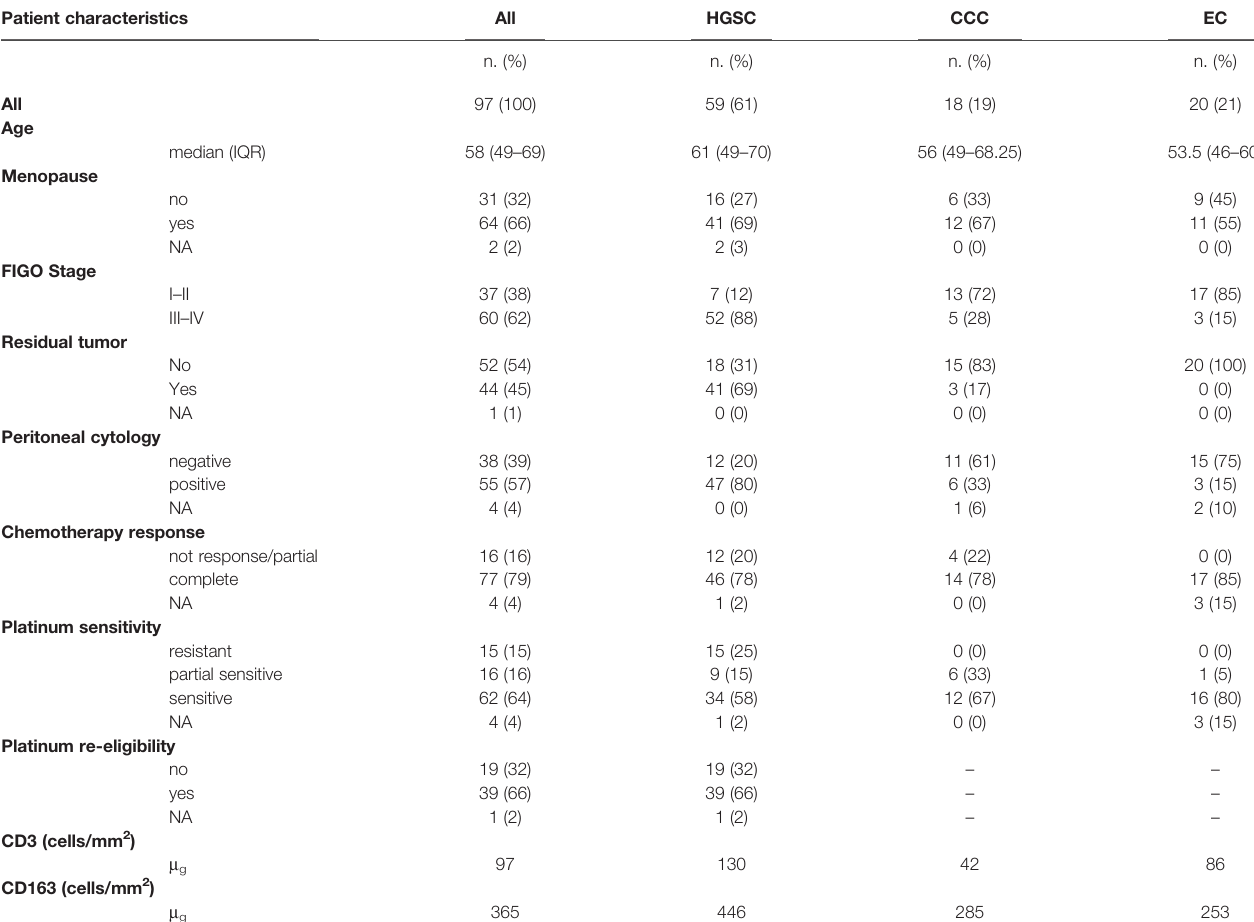
TABLE 1 | Clinicopathological features of the entire cohort of